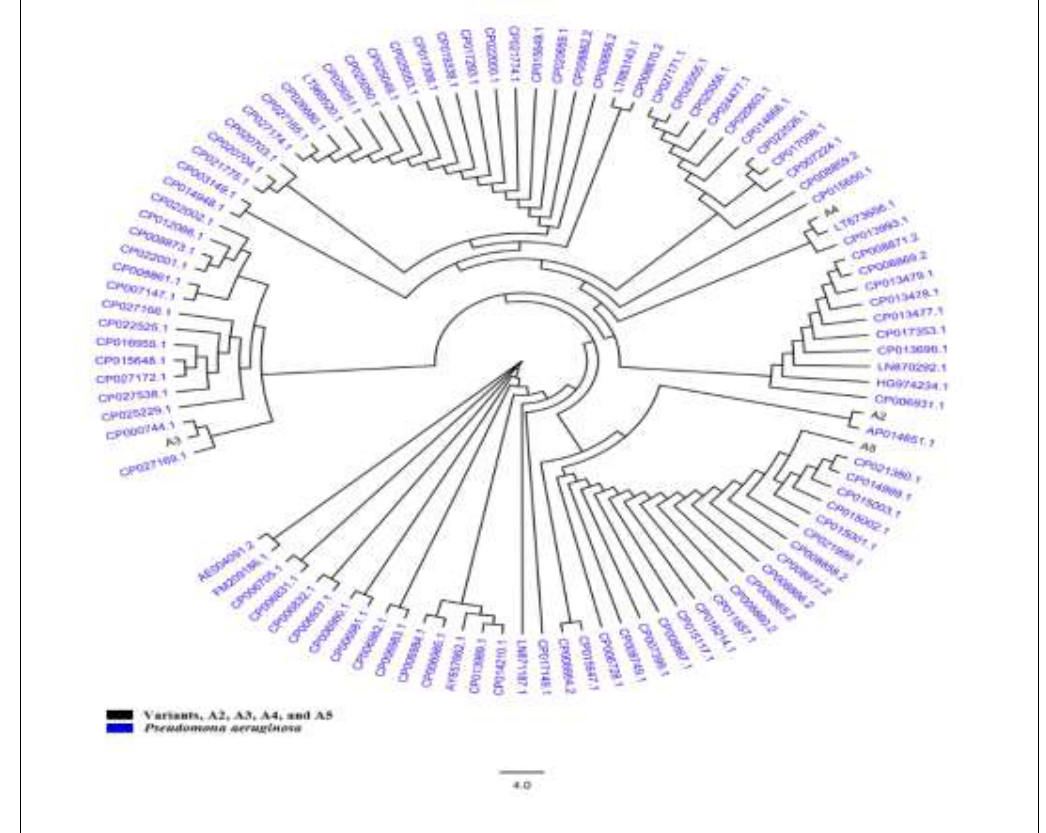
Figure (4): Analysis of Phylogenetic Tree of QacE gene (311 base pairs) of Pseudomonas aeruginosa Isolates. The Black Colour Indicates the Heterogeneities of Ps-2, Ps-3, Ps-4, and Ps-5 While the Blue Colour Indicates the Reference Pseudomonas aeruginosa Obtained from The NCBI